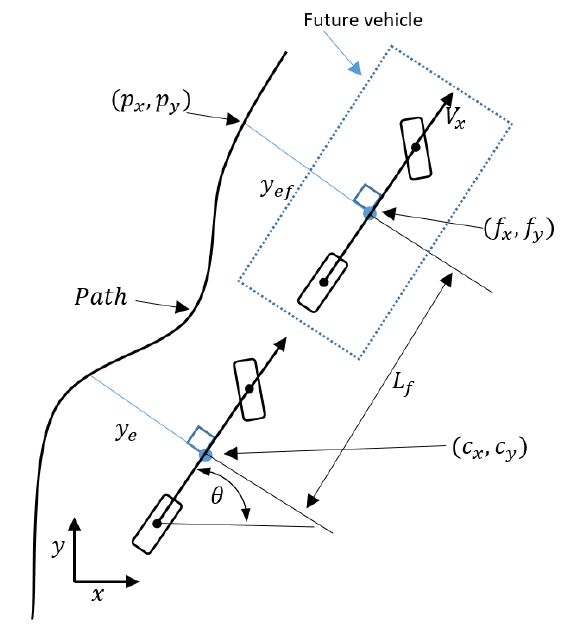
Figure 5. The future vehicle of the future prediction control